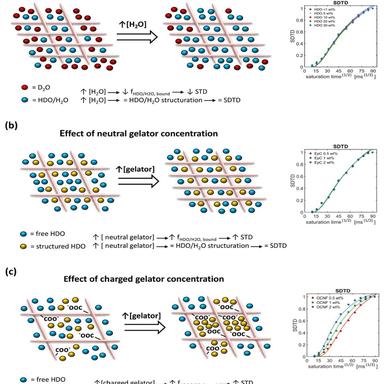
Summary of the main findings reported in this article. The effect of solvent (a) and gelator concentration, for neutral (b, EpC) and charged (c, OCNF) gelators, on the SDTD build-up curves and the degree of structuration of water within the gel network is shown.